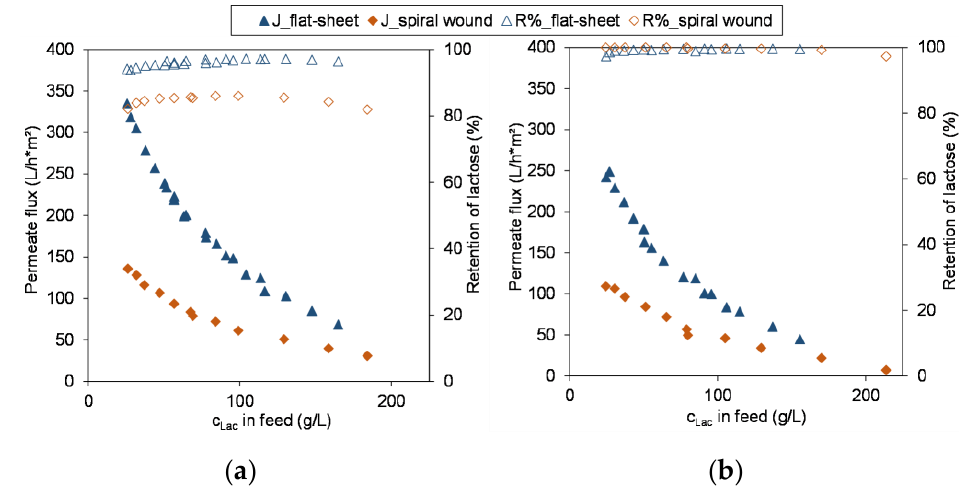
Figure 5. Comparison of membrane performance (flux (J) and retention (R%) of lactose (Lac)) of flat-sheet membrane versus 1812” spiral wound module for concentration of lactose model solution; ( a ) XN45 (45 °C & 3 MPa); ( b ) NFS (45 °C & 2 MPa). Operation parameters summarized in Table 3.